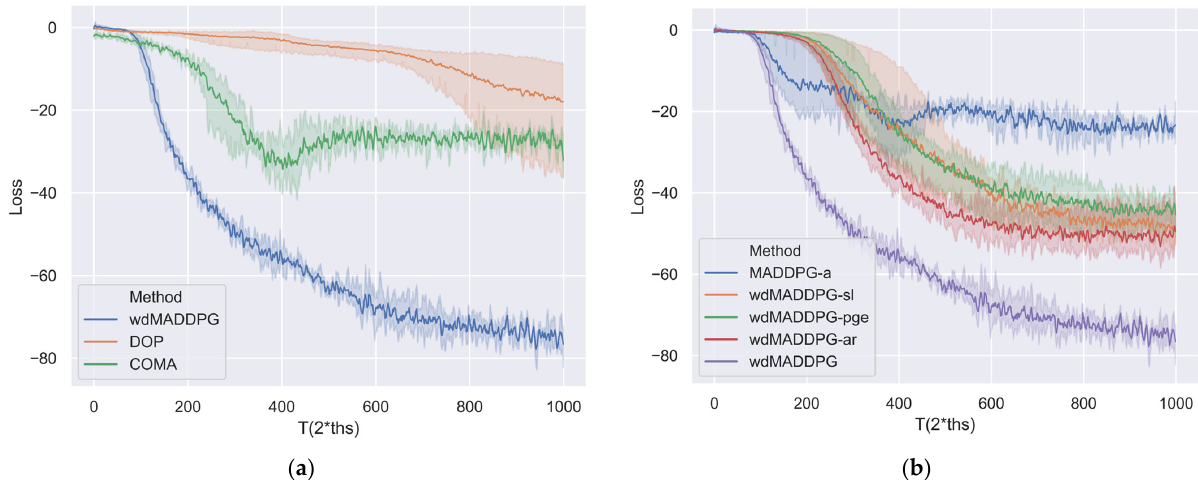
Figure 11. Mean loss values of different wargame decision-making methods and other methods based on the AC framework. The mean of loss values across five seeds is plotted and the 95% confidence interval is shown as shaded. ( a ) Comparison experiments with other methods based on the AC framework; ( b ) Ablation experiments.